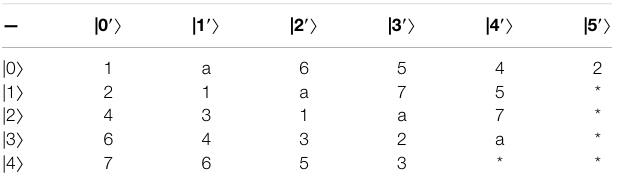
TABLE 11 | 7×3+1×4=25-member.